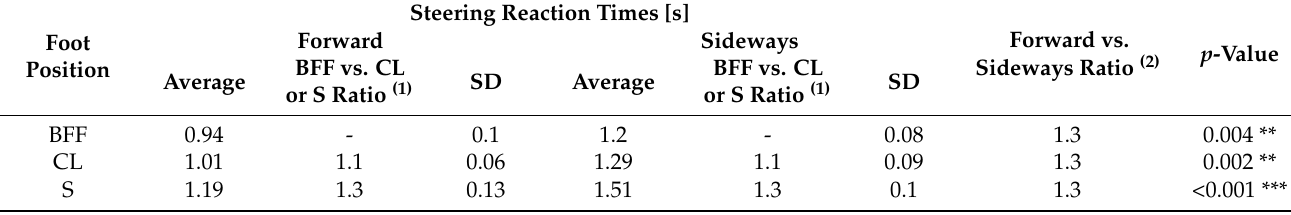
Table 5. Steering reaction times.